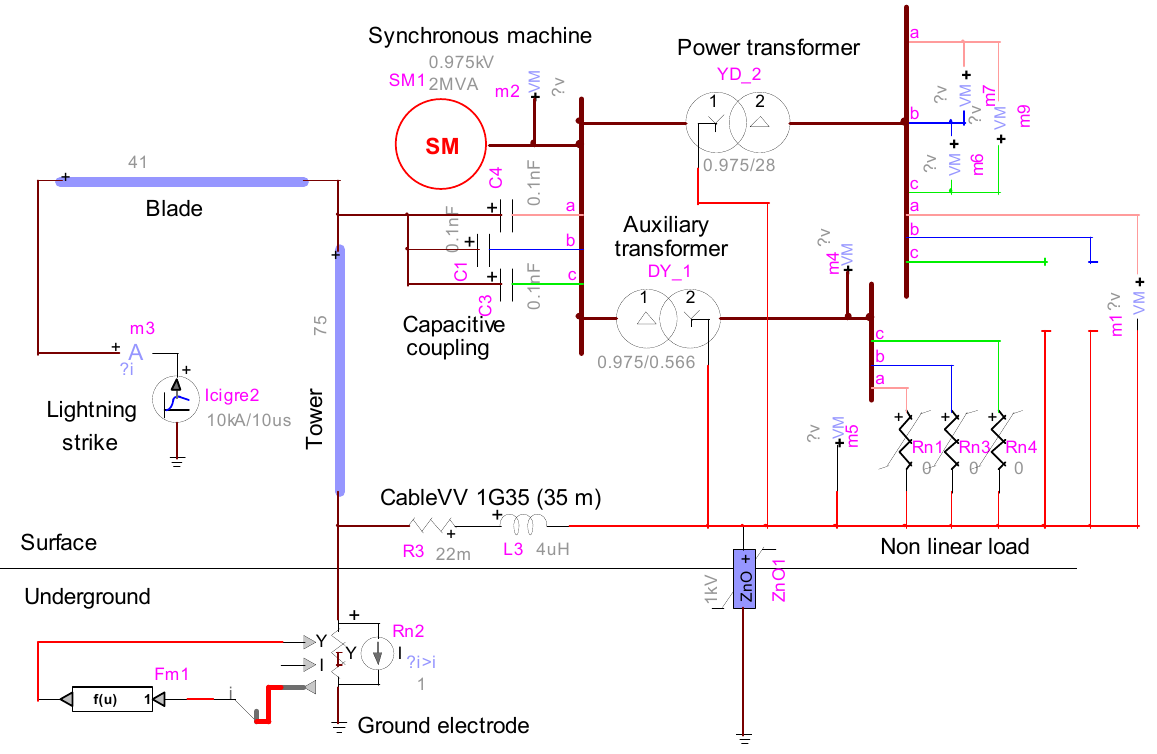
Figure 12. EMTP-RV circuit with SPD ideally